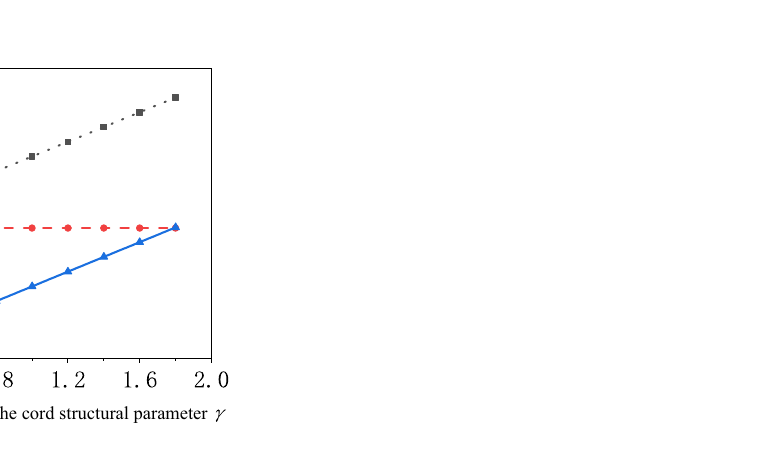
Figure 9. Scale-down variation of the stiffness of the air spring with the cord layer structural parameter.